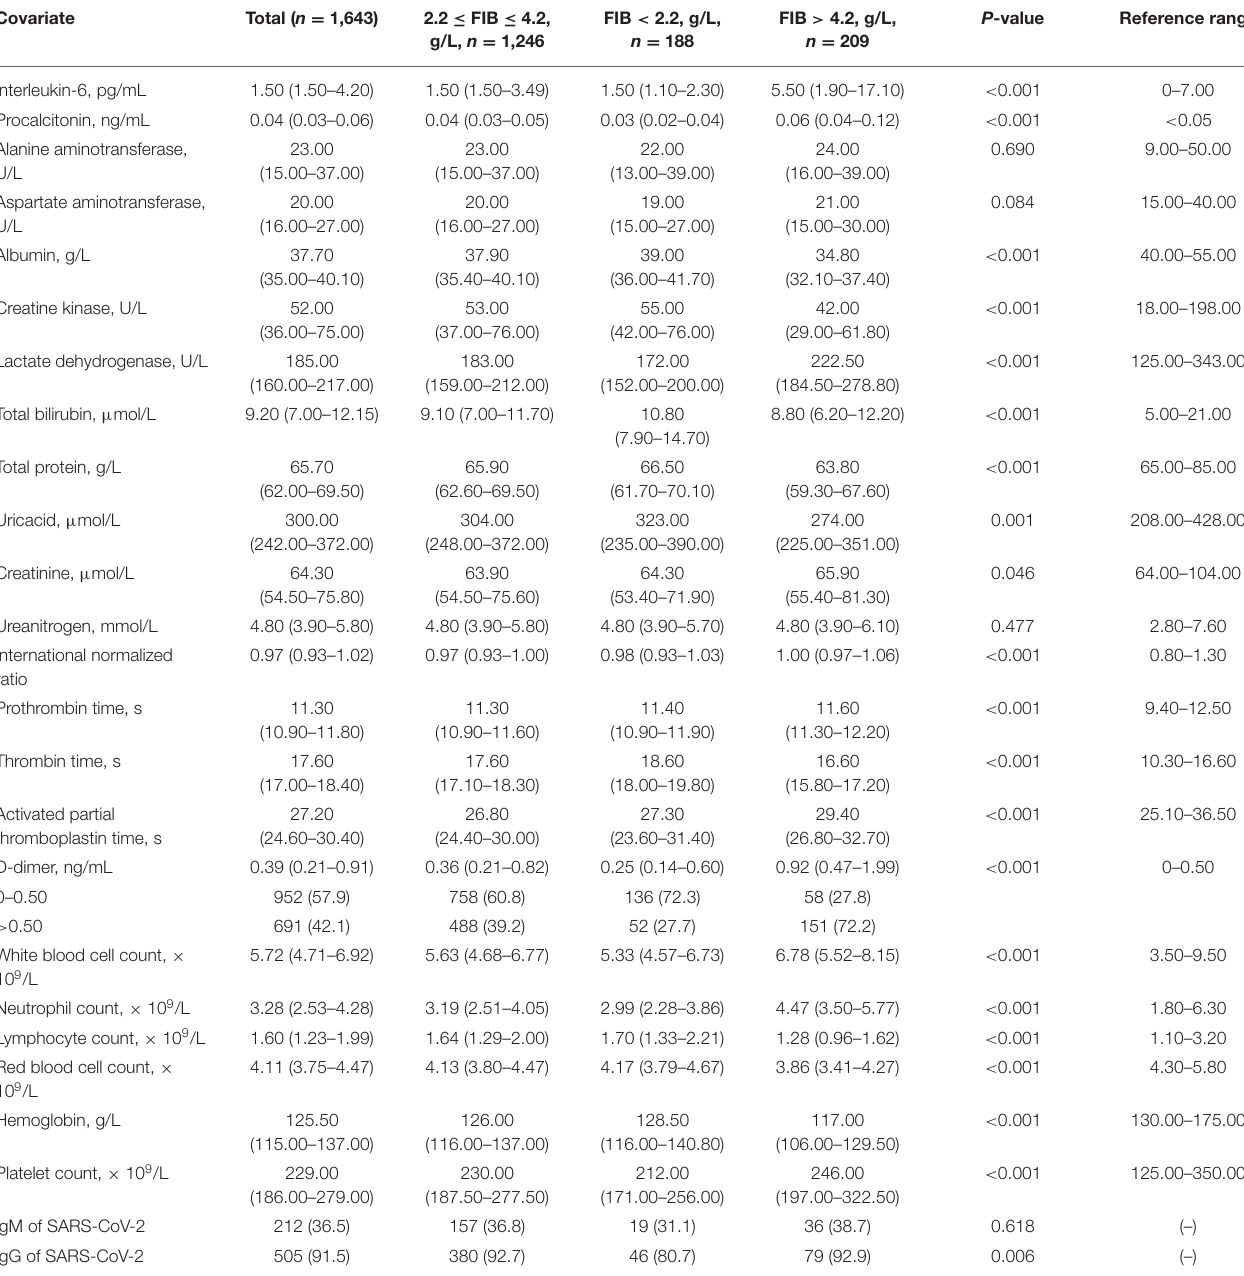
TABLE 2 | Laboratory results of 1643 patients with